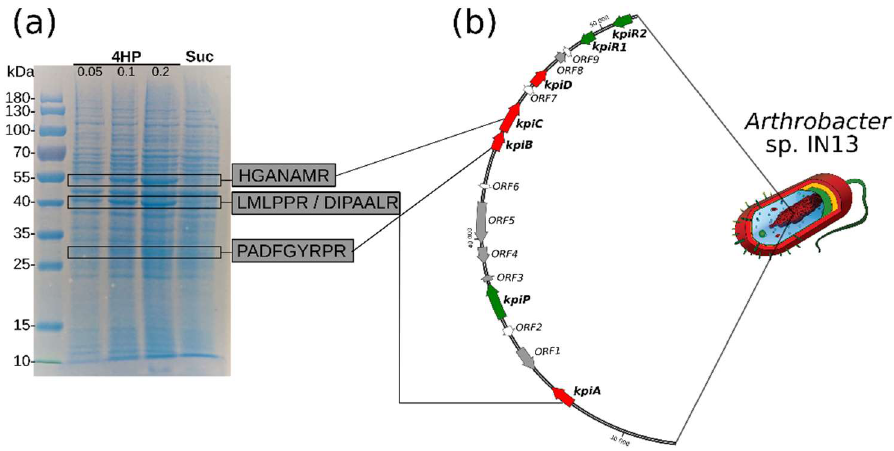
Figure 1. ( a ) Identification of 4-hydroxypyridine (4HP)-inducible genes in Arthrobacter sp. IN13. Bacteria were cultivated in minimal medium supplemented with 0.1% succinate (lane Suc) or 0.05–0.2% 4HP (lanes 4HP) as a single source of carbon. The positions of molecular mass markers are shown on the left of the gel (in kilodaltons). The peptide sequences identified by MS / MS proteomics are indicated in grey rectangles. ( b ) The organization of Arthrobacter sp. IN13 kpi gene locus and its flanking regions. Red arrows indicate genes that are known to be involved in the degradation of 4HP; green arrows indicate transport system and regulatory genes; grey arrows indicate transposases and pseudogenes; white arrows indicate hypothetical genes.